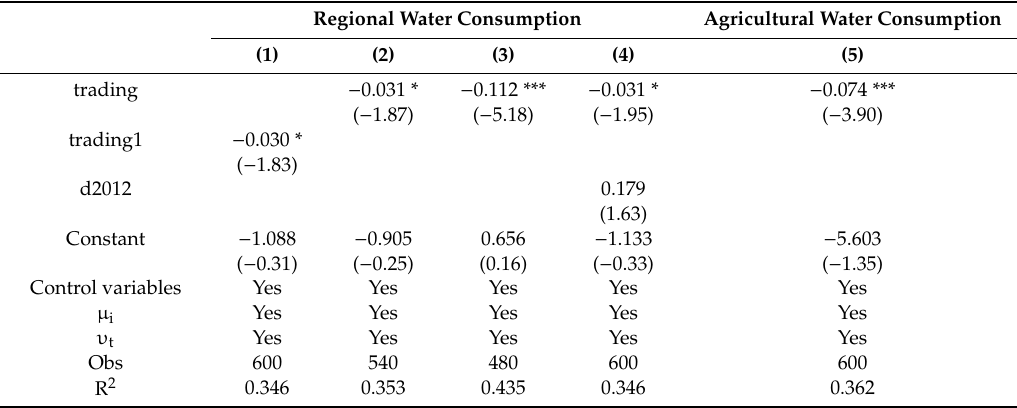
Table 3. Robustness